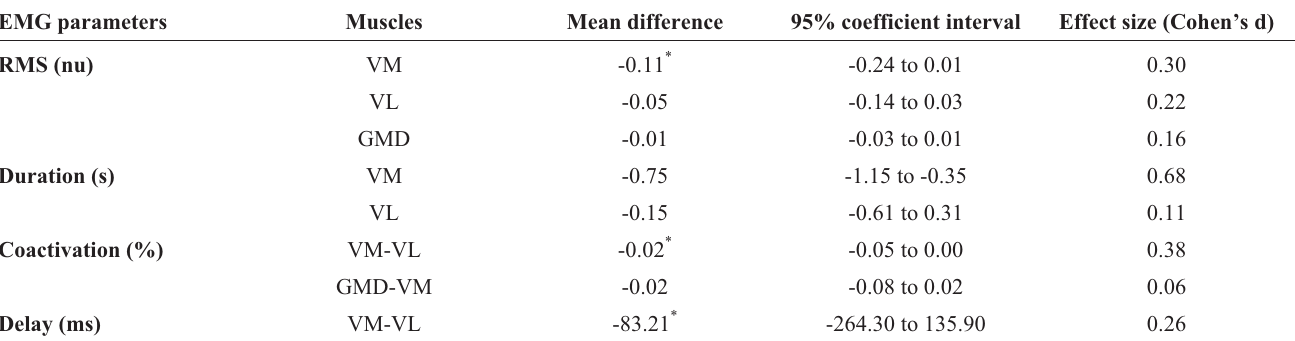
Table 4 - Data of mean difference, 95% coefficient interval and effect size of the EMG parameters in squatting in isometric hip abduction. EMG